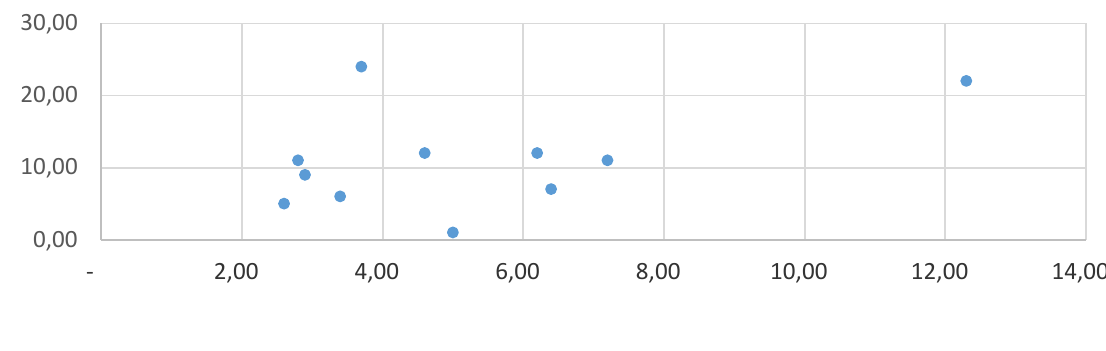
Figure 3. Y – Credit risk, X – GDP